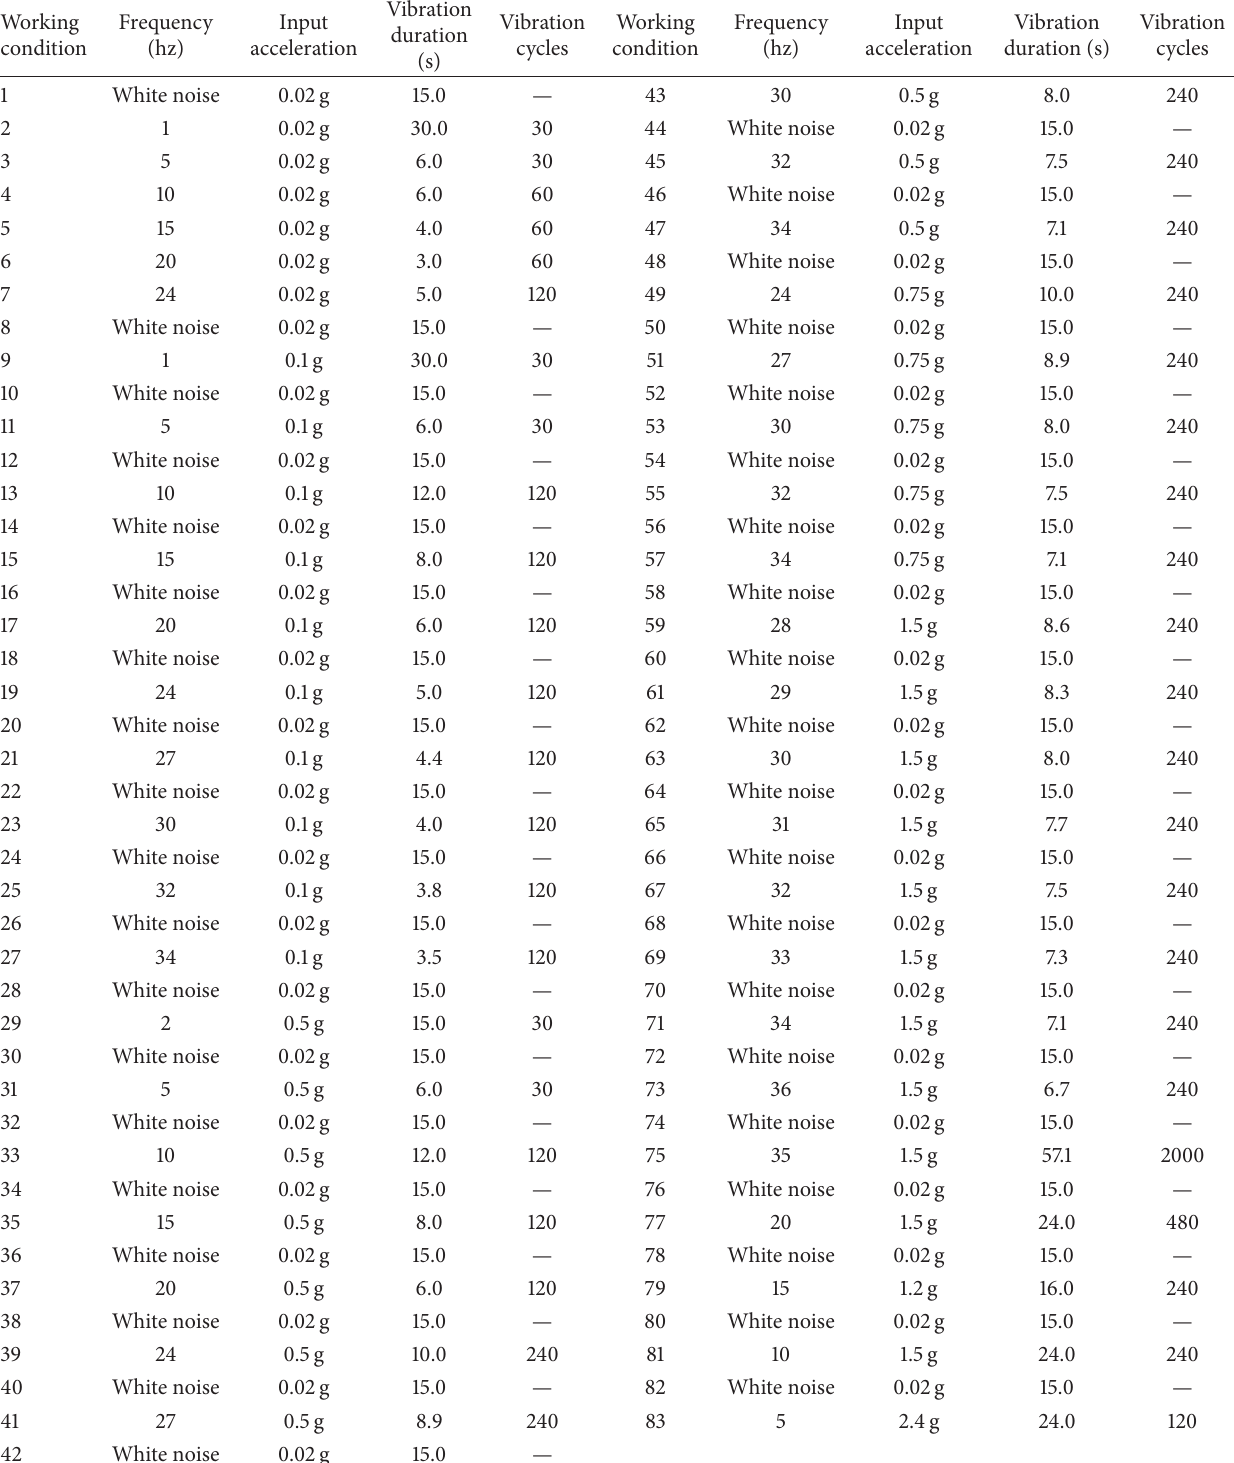
Table 5: Setting of experimental